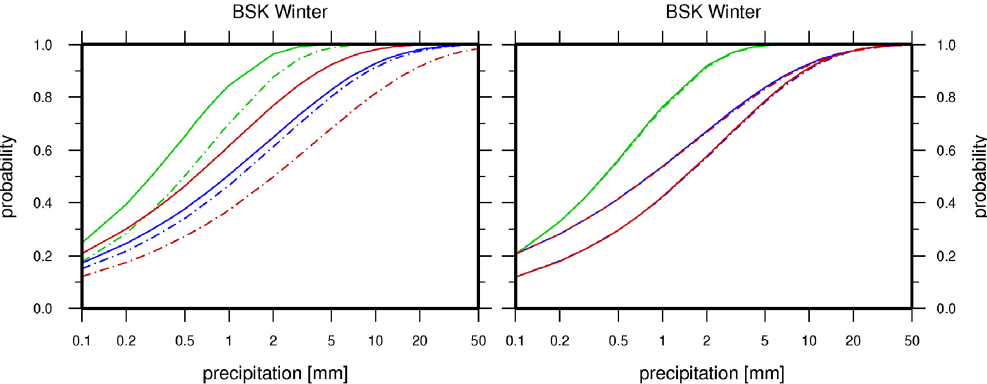
Fig. 4. Cumulative distributions of precipitation amount in winter (December–February) at Bou Skour. Left: the first subset (solid lines) contains the first half, the second subset (dashed lines) the second half of all precipitation days. Right: periods are split according to even (solid lines) and odd (dashed lines) entry numbers. Blue=observations, green=interpolated reanalysis data,